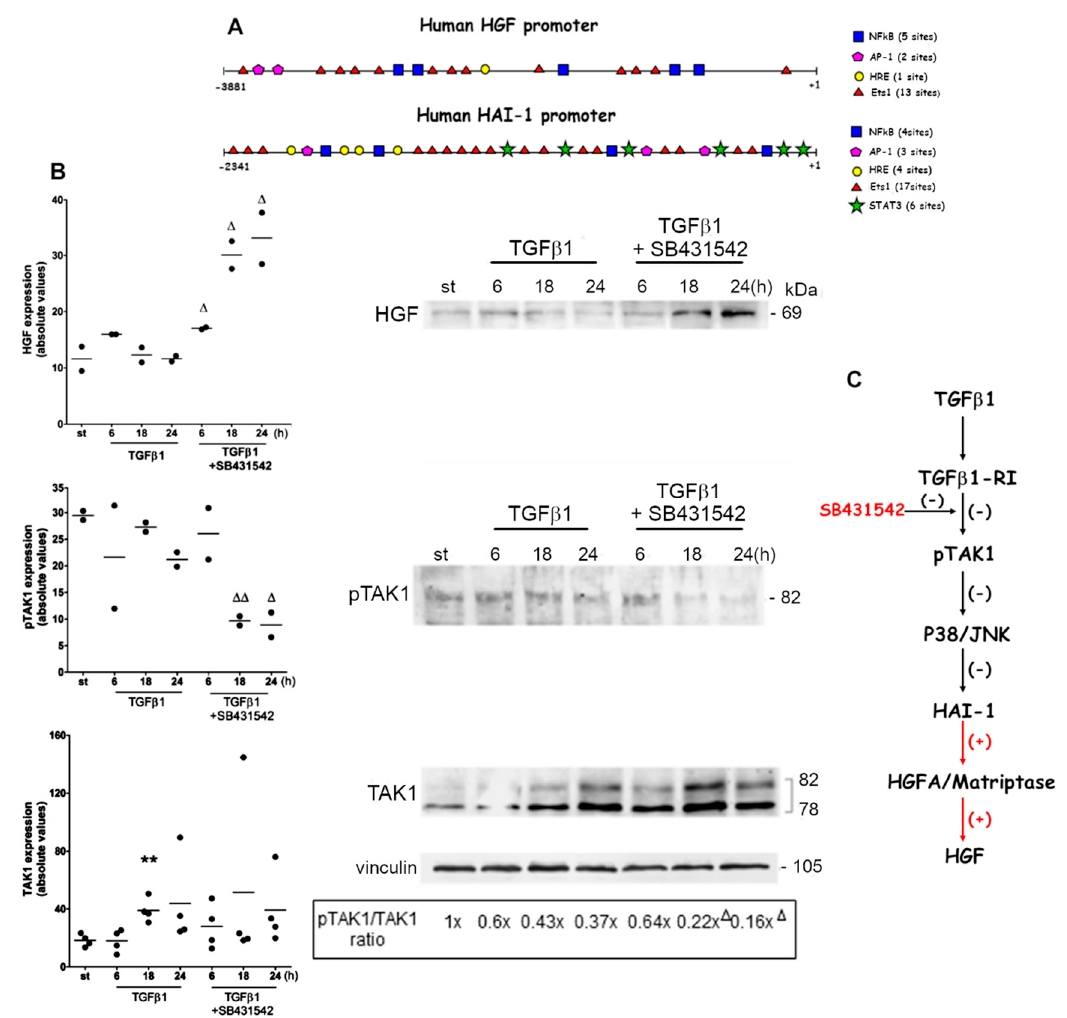
Figure 6. E ff ect of TGF β 1 exposure under TGF β 1-RI blockade on HGF formation. ( A ) Transcription factor binding sites in human HGF and HAI-1 promoters are reported. ( B ) Representative images of Western blots are shown; vinculin was used for normalization. The dot blots report the data of the Western blot experiments, which have been repeated two times for HGF and phosphoTAK1 immunoblotting, and four times for TAK1 immunoblotting. The pTAK1 / TAK1 ratio was reported as fold-variations, that were calculated versus the starvation value. ** P < 0.005 versus the starvation value; ∆ P < 0.05, ∆∆ P < 0.005 versus TGF β 1-treated cells at the corresponding time. ( C ) Schematic representation of the pathway leading to HGF formation under SB431542 treatment of TGF β 1-exposed 1833 cells. ( − ) Pathway inhibition; ( + ) pathway activation.